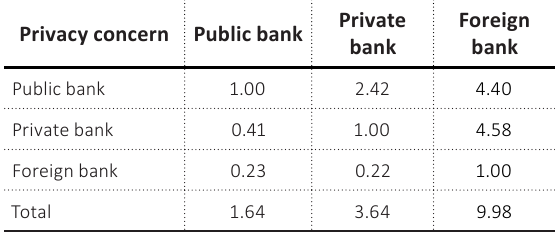
Table 5. Pairwise comparison matrix of various aspects of security